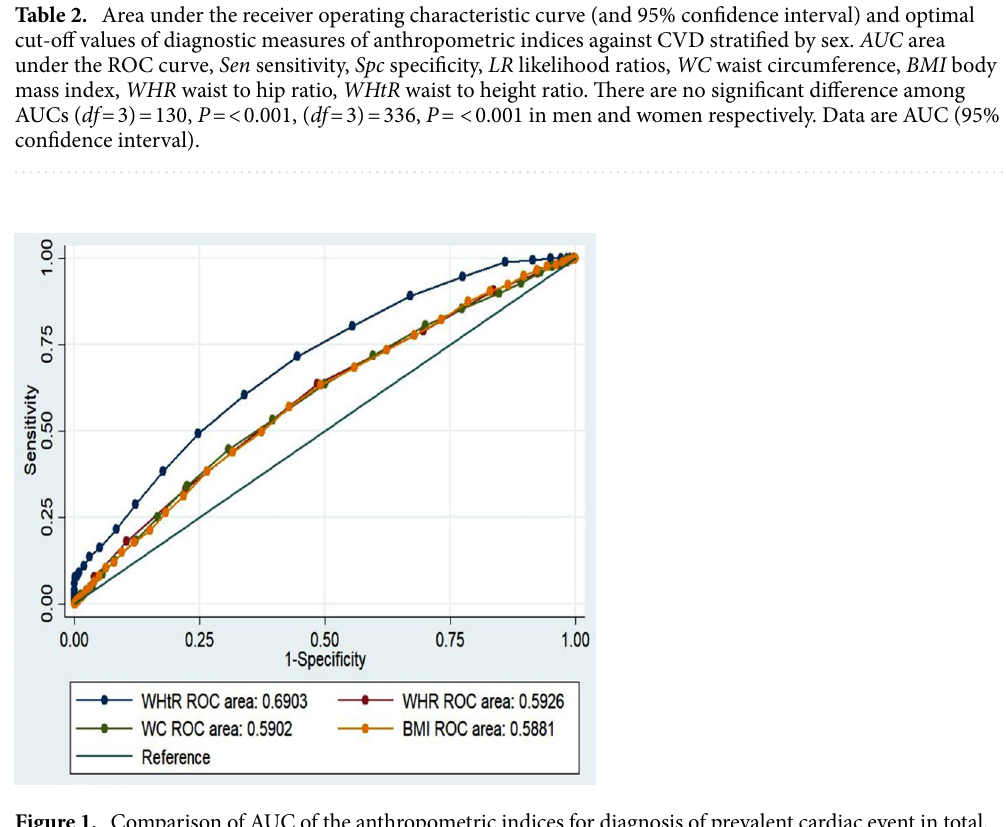
revealed for BMI and WC (71%, 43%). The optimal cut-off value of WC in the males was > 96 cm, which was lower than that in the females, i.e. 99 cm; on the other hand, the optimal cut-off for WHtR was > 0.66 in the females, 0.56 in males. Both parameters were found to be better than BMI. The best cut-off value for BMI was > 27.02 kg/m 2 in the males, while it was > 27.60 kg/m 2 in the females. WHtR showed the highest likelihood ratios (3.2, 1.4) in men and women, receptively. The LR+ (positive Likelihood Ratio) for WHtR was 3.2 in male, 1.4 in females, subjects were 3.2 (2.6–3.9) and 1.4 (1.3–1.6) times more likely to have cardiac events, respectively (Table 2) (Figs. 1, 2). One analysis assessed the accuracy of the anthropometric index in defining the CVD events. The percent- age of individuals classified on the basis of each of the anthropometric indices for the general population was 55% by WHtR, 51% by WC, 49% by BMI and 30% by WHR. In the general population, ROC analysis displayed that WHtR could be a better predictor of CVD events than other anthropometric indices. More importantly, in women, the percentage of individuals classified for WC and BMI was greater than that based on WHtR (Table 2) (Figs. 2, 3).